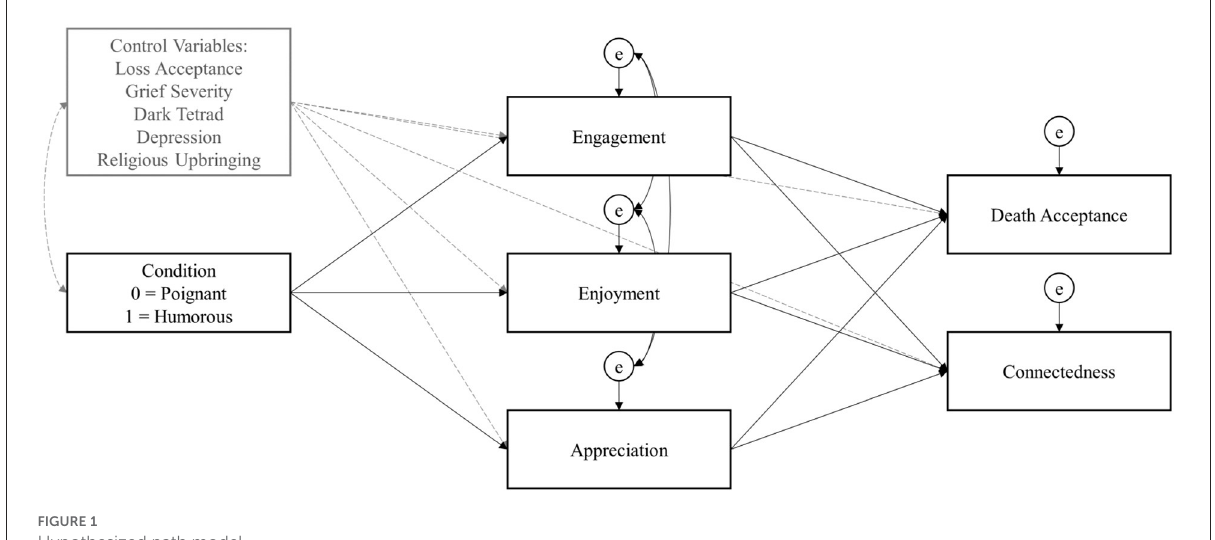
FIGURE1 Hypothesized path model.